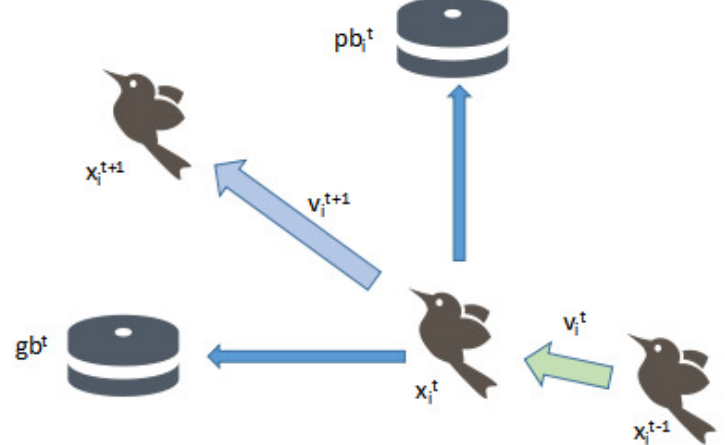
Figure 1. Schematic diagram of particle